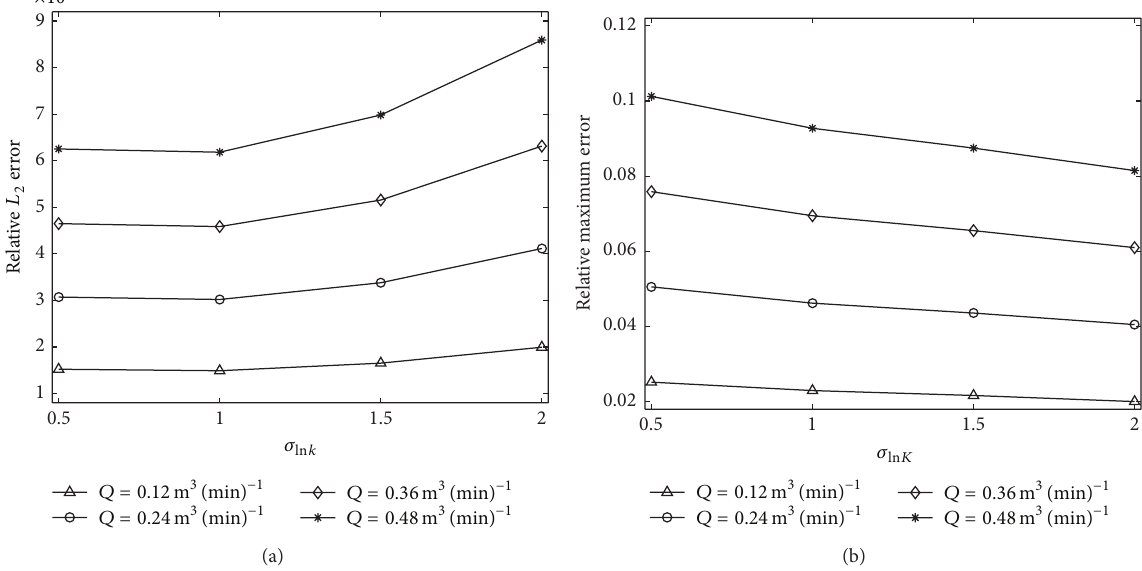
Figure 12: Relative (a) 𝐿 2 and (b) maximum errors between the fine-scale model and the new scheme for the steady flow problem with well